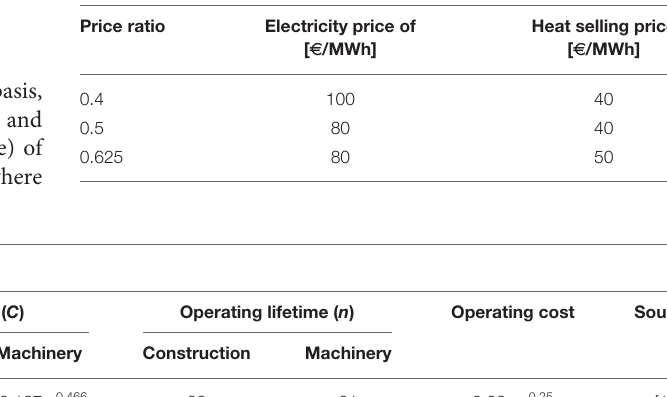
TABLE 5 | Price ratios of electricity price to heat selling price.